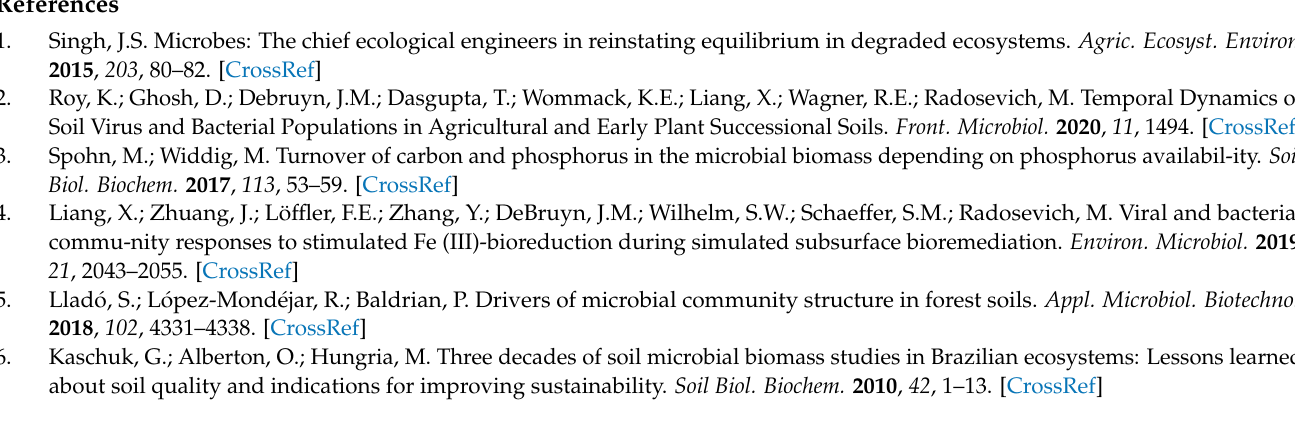
Table S2: Soil physiochemical factors and SMB in sample plots at different